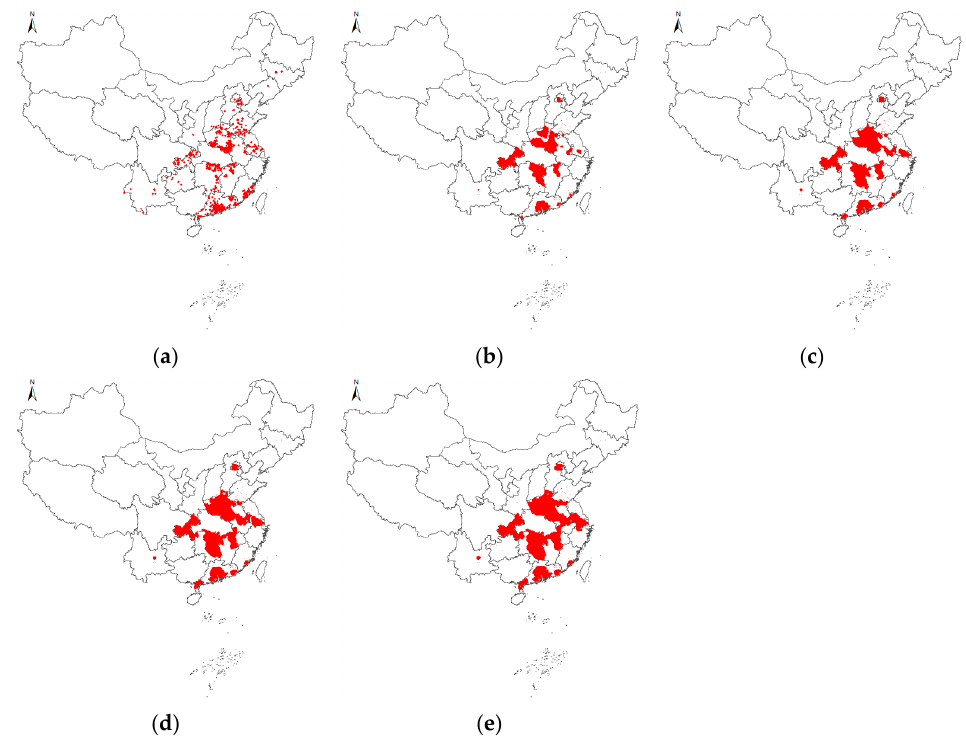
Figure 11. COVID-19 spread under tighter control measures. ( a ) 6 February 2020 (actual data); ( b ) 16 February 2020 (simulated data); ( c ) 26 February 2020 (simulated data); ( d ) 7 March 2020 (simulated data); ( e ) 20 March 2020 (simulated data).